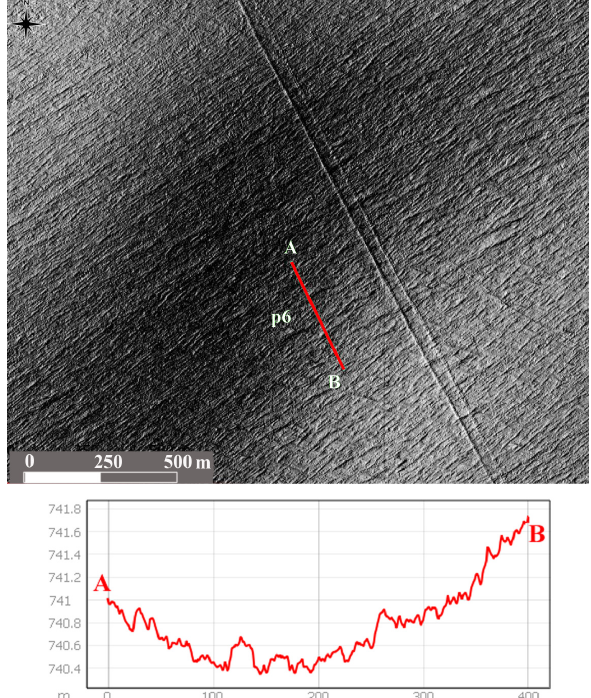
Figure 7. Microtopographic snow/ice features of eolian origin at the site 4: the 1-m gridded hill-shaded map and a cross-section A–B. One can see snow/ice microfeatures of eolian origin, as well as the sledge route crossing the site. For the site location, see Fig. 1